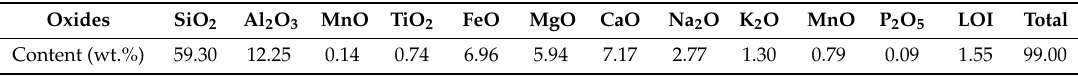
Table 2. Chemical composition of the